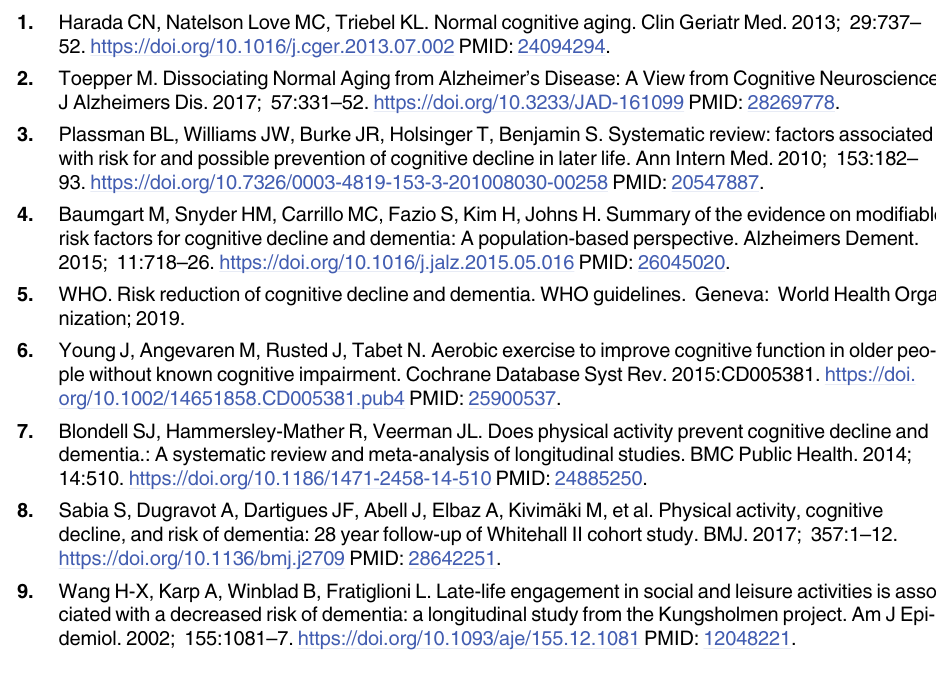
S1 Table. 3C cohort design. S2 Table. Participants’ characteristics according to their leisure and sport activities level, n =